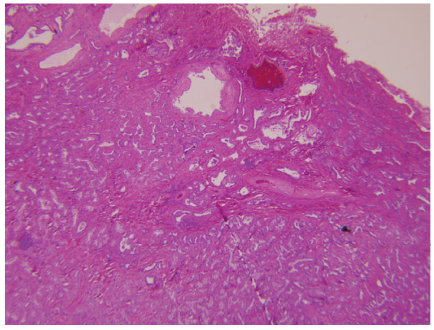
Figure 2: Conventional biliary adenofibroma, H&E 4x.